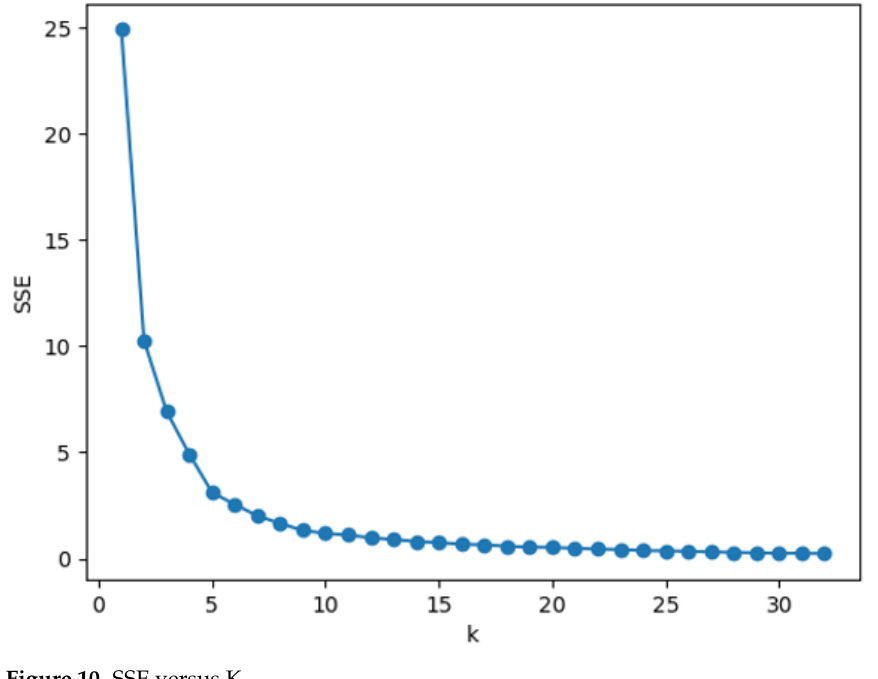
Figure 10. SSE versus K.